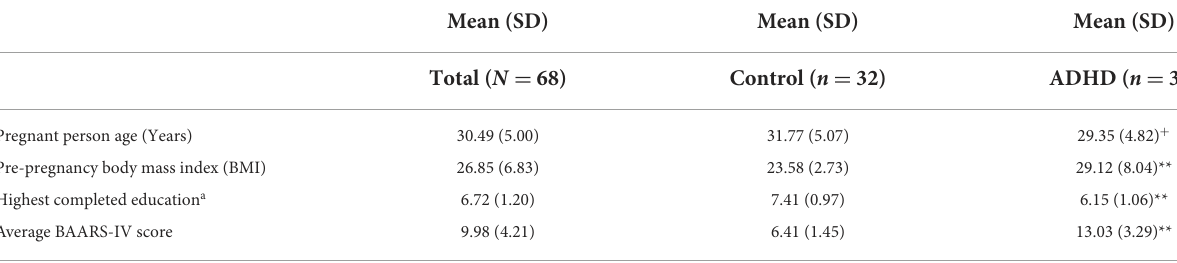
TABLE 1 Sample demographic information ( N =